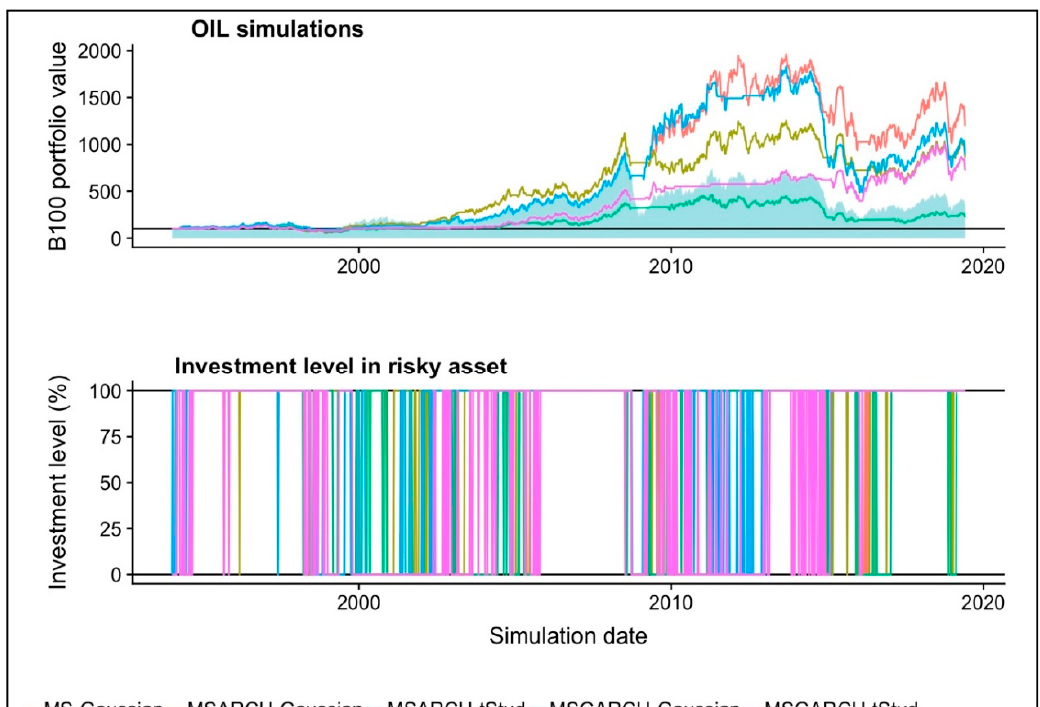
Figure 1. Historical performance of the five simulated scenarios of the investment strategy in the WTI oil continuous price one-month future and its historical investment level. Source: Own elaboration with results of our simulations and data from Refinitiv Eikon [72].